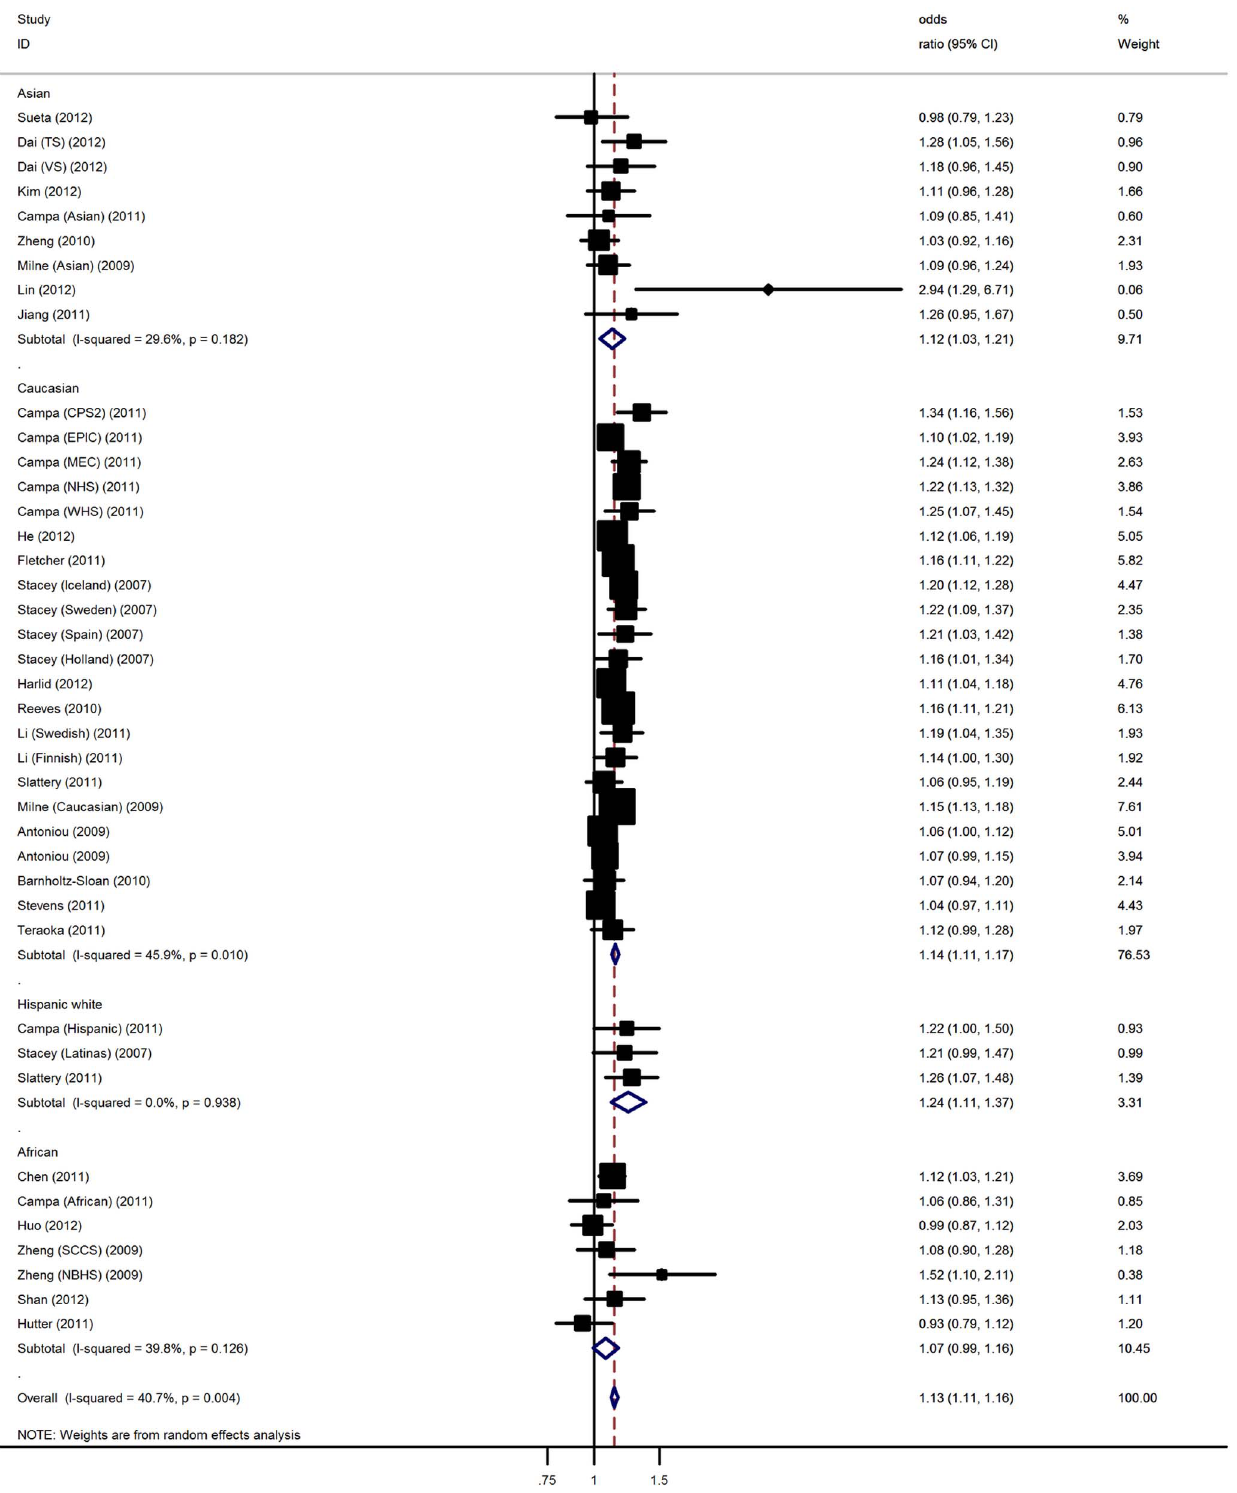
Figure 1. Forest plot for association of 2q35-rs13387042 polymorphism and BC risk.